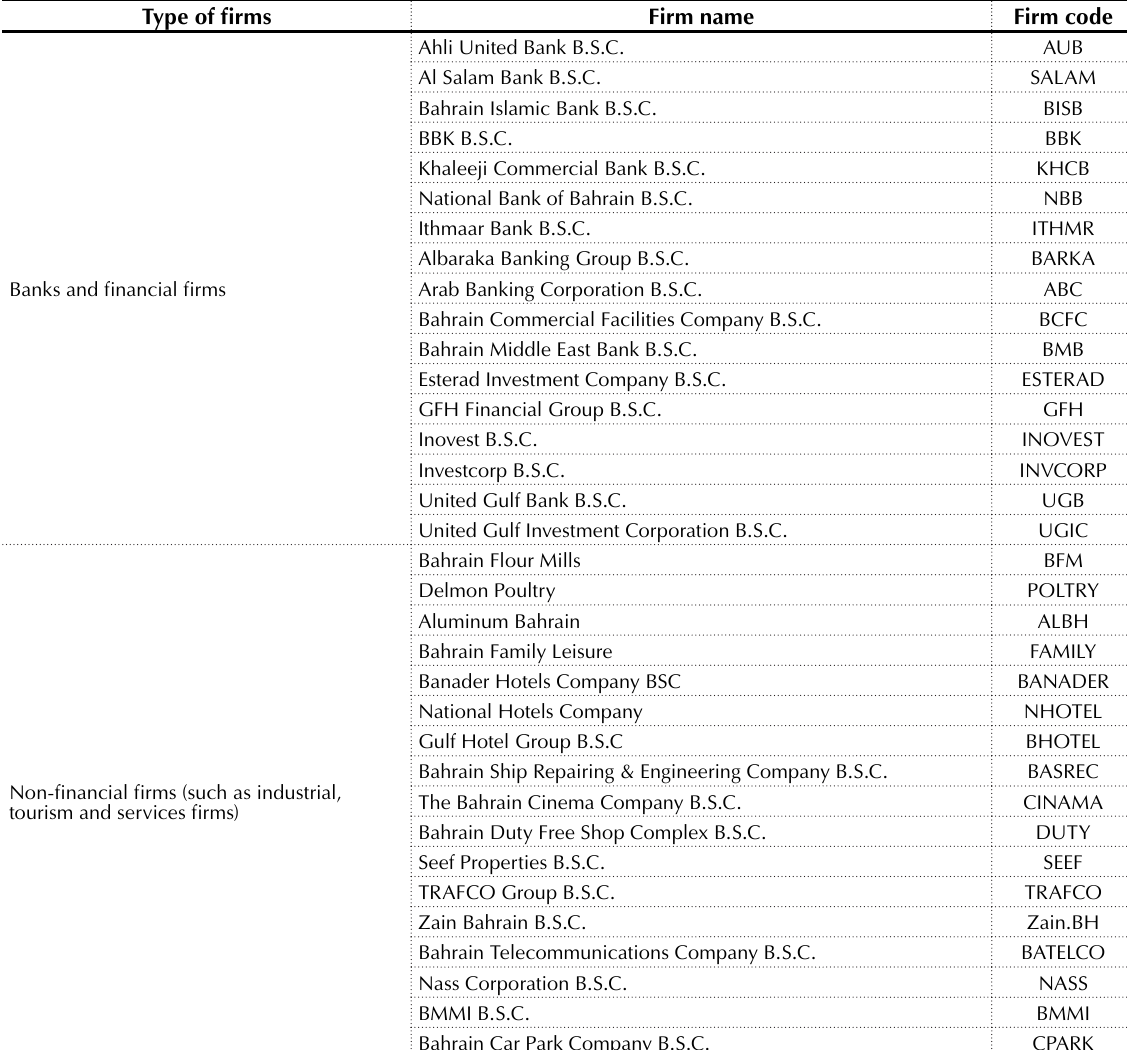
Table C1. List of firms included in the sample of the